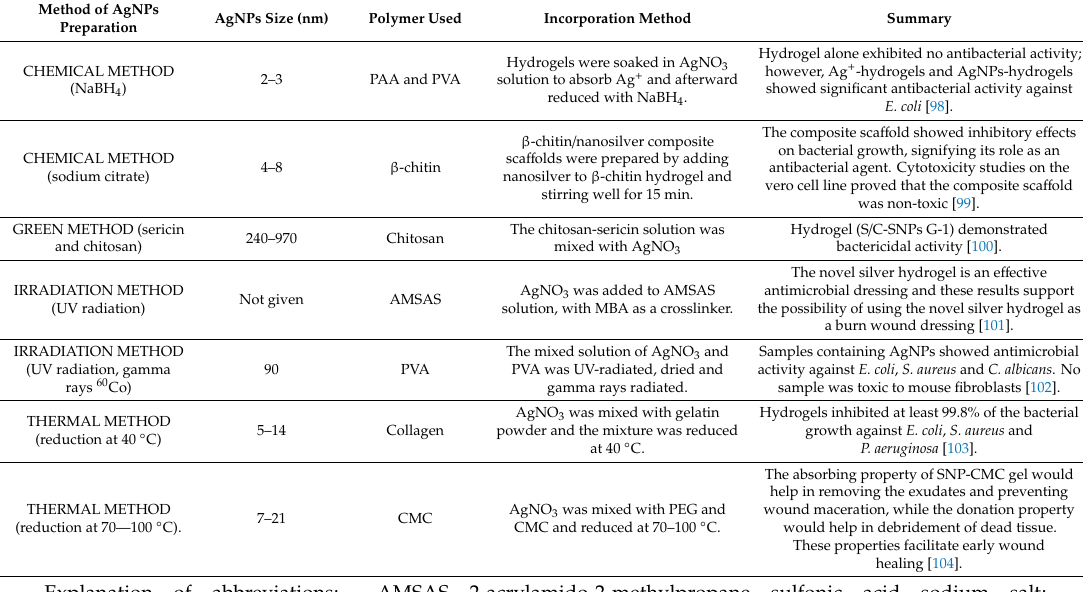
Table 4. AgNPs hydrogels for wound